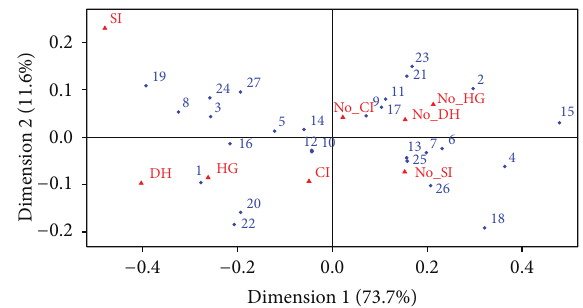
Figure 1: Correspondence analysis of adverse events during RTX